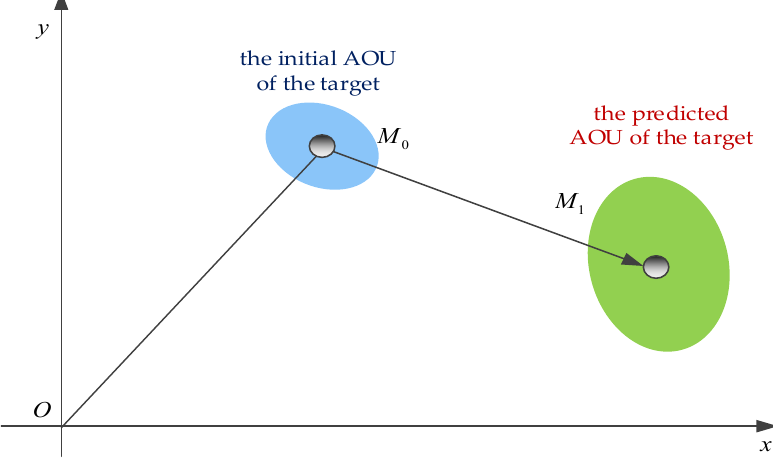
Figure 1. The schematic diagram of AOU for moving target.